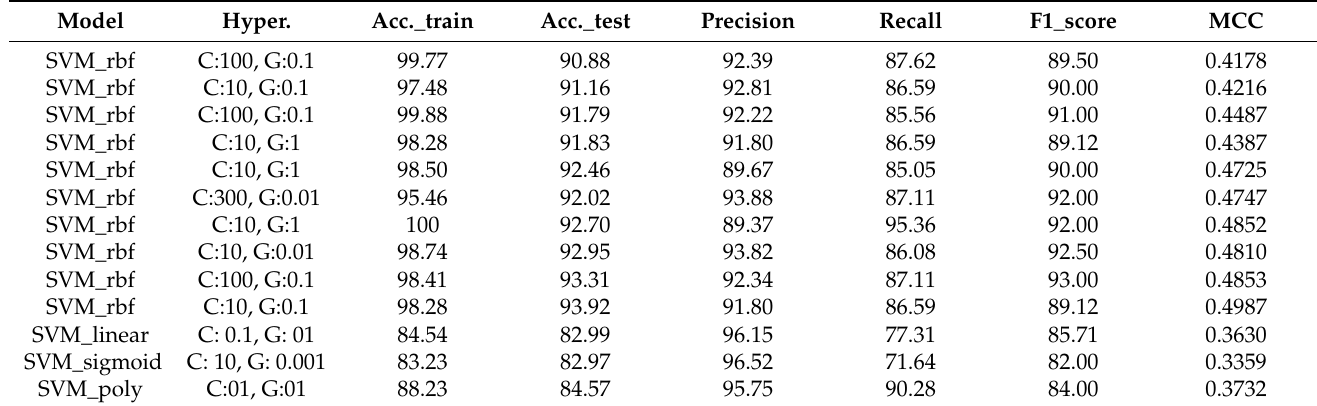
Table 4. Performance of ML models on balance data while utilizing FEB.